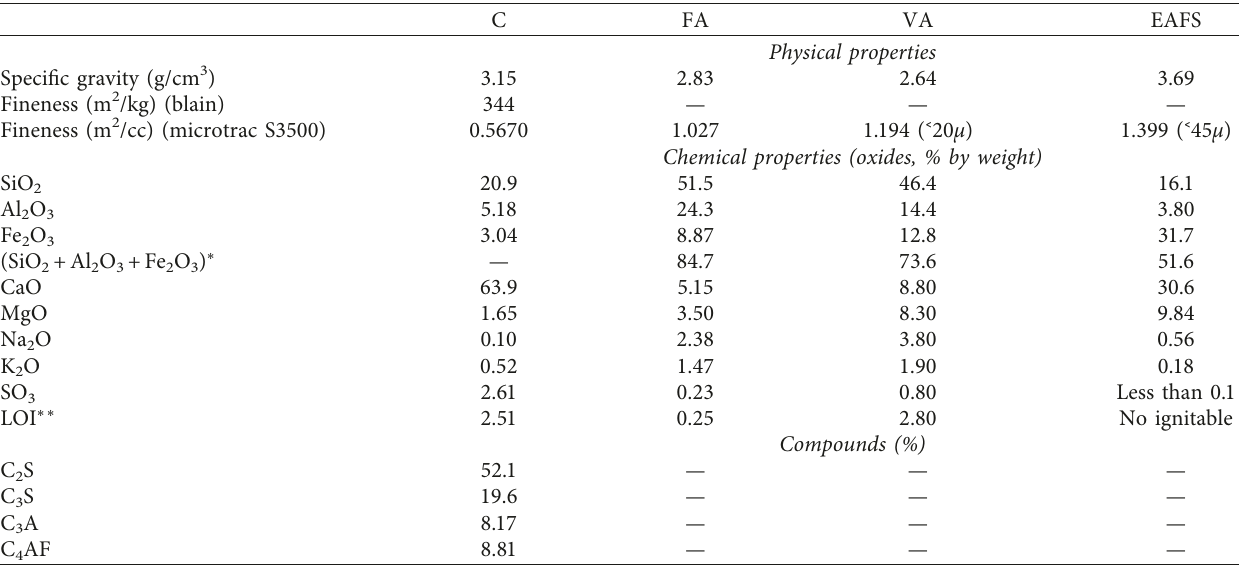
Table 2: Physical and chemical analysis of cement and